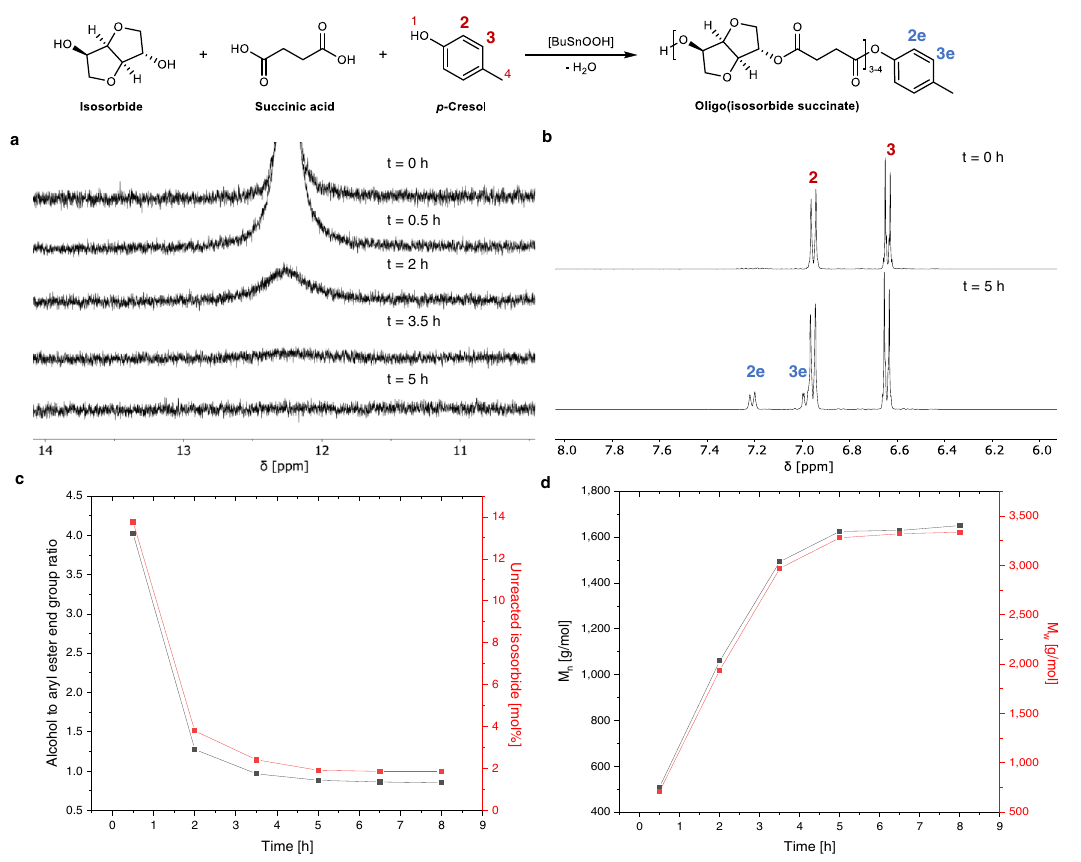
Fig. 3 | Esteri fi cation between succinic acid, isosorbide, and p -cresol. a 1 H NMR spectrum showing the disappearance of succinic acid ’ s carboxylic acid proton around 12 ppm after 0h, 0.5h, 2h, 3.5h, and 5h. b 1 H NMR spectrum of aromatic region upon formation of a clear melt ( t =0) and after 5h esteri fi cation at 240°C but before p -cresol removal. For a fully assigned 1 H NMR spectrum of the reaction melt after esteri fi cation, see Supplementary Fig. 2. c Evolution of the alcohol ( exo - and endo -OH groups of isosorbide) to ester end group (cresyl succinate) ratio during esteri fi cation with the amount of total unreacted isosorbide (respective